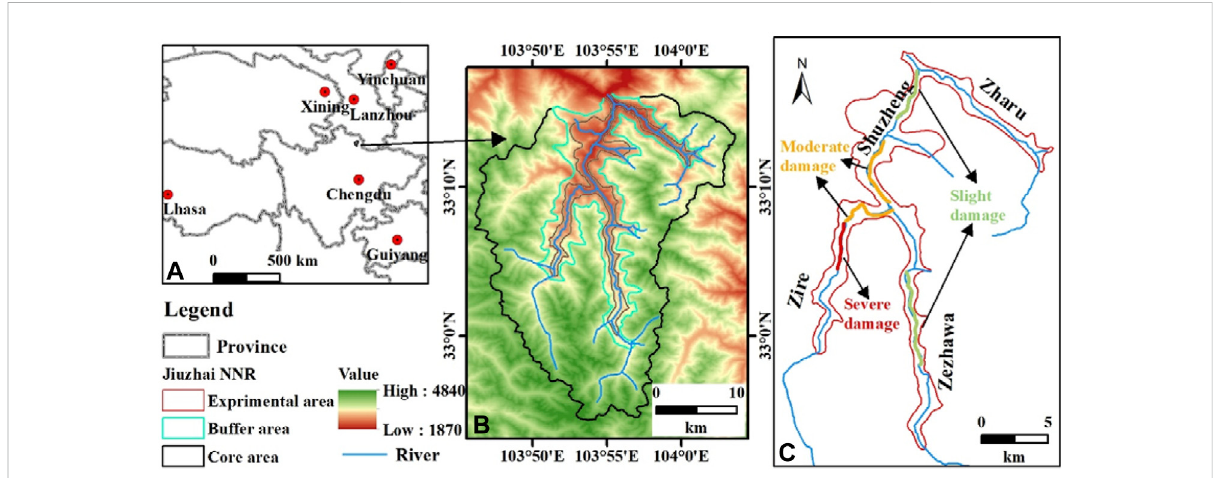
FIGURE 1 Information on the Jiuzhai World Natural Heritage (WNH) Site: (A) location of the Jiuzhai WNH Site in Sichuan Province, China; (B) the three biospherereserve zonesoftheJiuzhaiNationalNatureReserve(NNR)andcorrespondingelevationsbasedonASTER30-m digitalelevationmodels; and (C) damage conditions in Jiuzhai Valley, the experimental area of the Jiuzhai NNR.